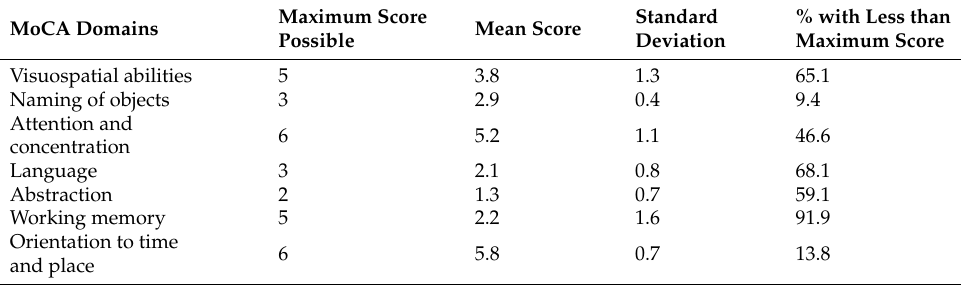
Table 2. MoCA domain scores at baseline ( n =